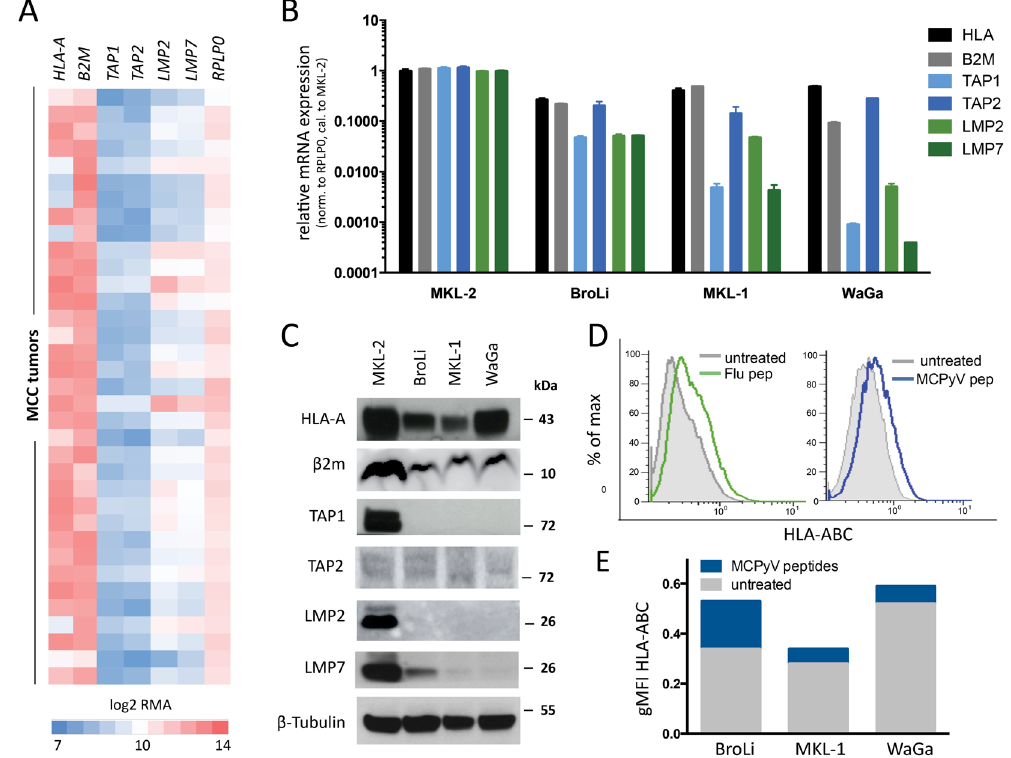
Figure 2. Reduced HLA class-I expression in MCC is associated with an impaired antigen processing machinery (APM). ( A ) RMA normalized expression values of gene expression array GSE22396, were obtained from the GEO database. RMA values were log2 transformed and are depicted as heat map with expression values ranging from 7 (blue = low expression) to 14 (red = high expression). HLA-A , B2M , TAP1 , TAP2 , LMP2 and LMP7 mRNA expression is shown in comparison to RPLP0. ( B ) mRNA expression of HLA-A ( black ), B2M ( grey ), TAP1 ( light blue ), TAP2 ( dark blue ), LMP2 ( light green ) and LMP7 ( dark green ) in 4 MCC cell lines was determined by RT-qPCR in triplicates using specific primers; C T values were normalized to RPLP0 and calibrated to a set of Δ C T s of MKL-2; relative mRNA expression is depicted as mean + SEM. ( C ) Protein expression in 4 MCC cell lines was determined by immunoblot of whole cell lysates using antibodies specific for HLA-A, β 2 m, TAP1, TAP2, LMP2 and LMP7; β -tubulin served as loading control. ( D , E ) MCC cell lines with low (BroLi, MKL-1) and intermediate (WaGa) HLA class-I surface expression were incubated with saturating amounts (10 µ M) of a flu peptide mix or MCPyV encoded large and small T antigen and VP1 derived epitopes binding with high affinity to the respective HLA-A molecules or an irrelevant peptide cocktail for at least 24 h (WaGa and MKL-1) or 48 h (BroLi). HLA class-I surface expression was determined by flow cytometry using an HLA-ABC detecting antibody. Induction of HLA class-I surface expression after stabilization with a flu peptide mix (green line), exemplarily shown for MKL-1, or the specific MCPyV peptide mix, exemplarily depicted for BroLi (blue line). An irrelevant peptide cocktail (grey filled) was used as control ( D ). Comparison of HLA class-I surface expression is depicted as geometric mean fluorescence intensity (gMFI) after incubation with MCPyV derived high affinity (blue) or an irrelevant peptide control (grey) for all analyzed MCC cell lines ( E